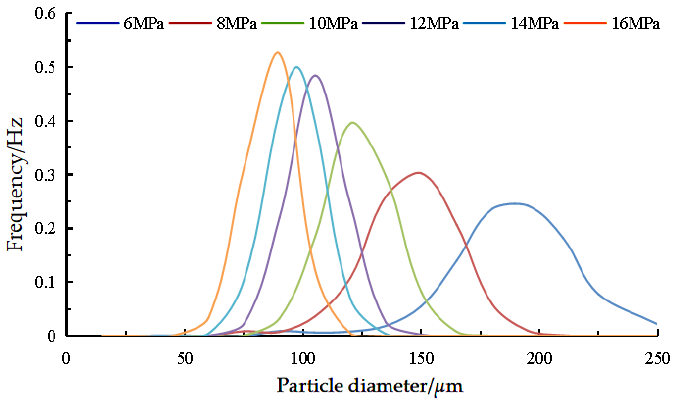
Figure 19. Particle diameter distribution.